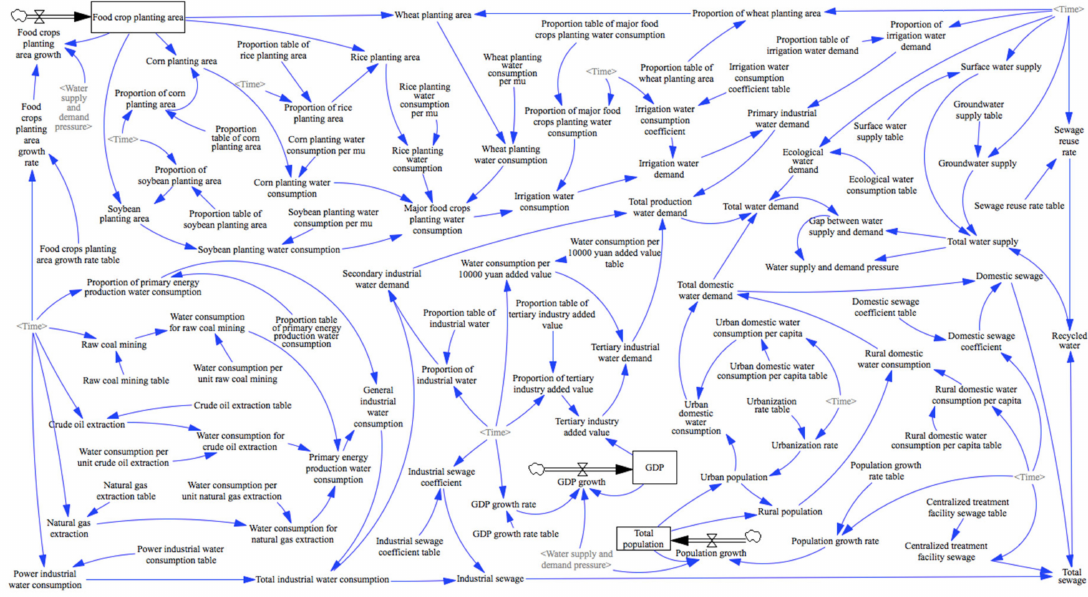
Figure 5. WEF nexus stock and flow